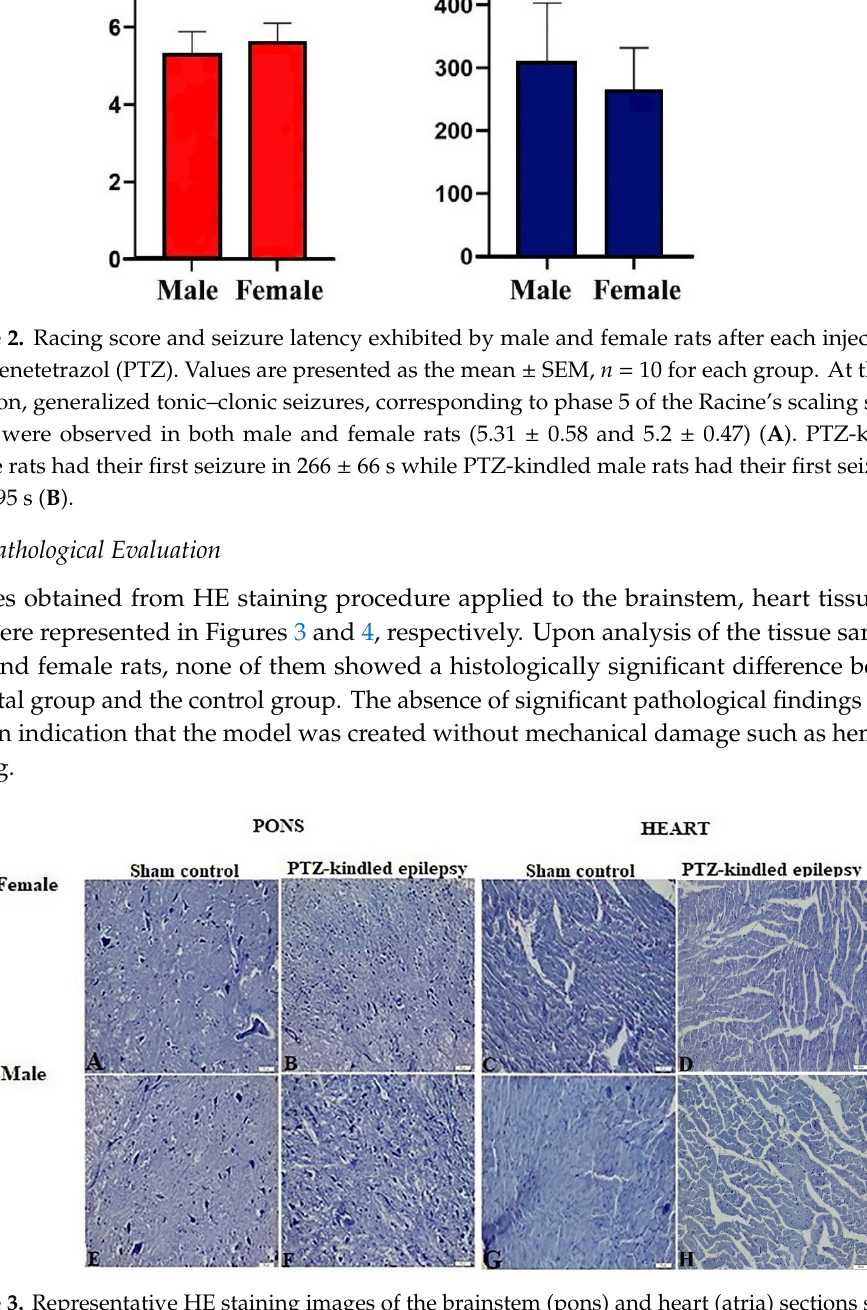
Figure 3. Representative HE staining images of the brainstem (pons) and heart (atria) sections stained with blue in sham control and PTZ-kindled epilepsy of rat model. For female; A : pons image of control groups, B : pons image of PTZ-kindled of epilepsy, C : heart image of control groups, D : heart image of PTZ-kindled epilepsy. For male; E : pons image of control groups, F : pons image of PTZ-kindled of epilepsy, G : heart image of control groups, H : heart image of PTZ-kindled epilepsy. Pictures were taken at the magnification of × 200. Scale bar: 50 µ